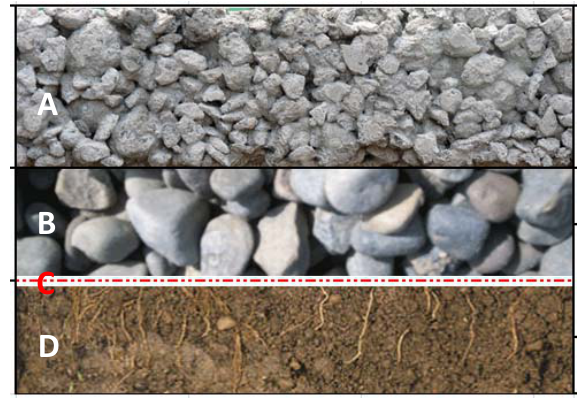
Figure 5. A typical pervious concrete pavement section: A – pervious concrete, B – clean drainage stone, C – nonwoven geotextile, D – underlying